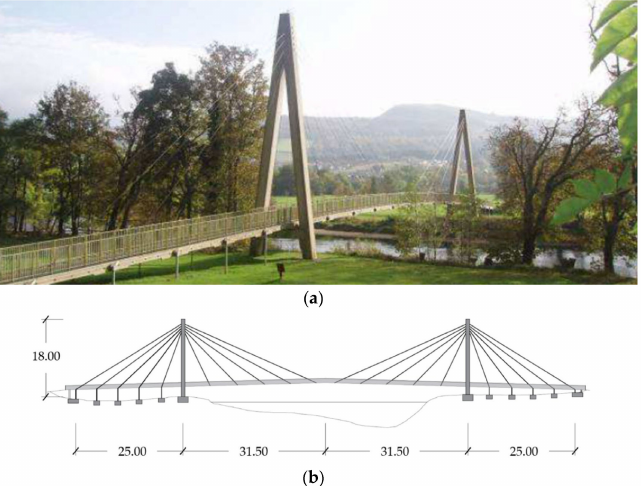
Figure 1. Aberfeldy footbridge: ( a ) the general view [29] and ( b ) the longitudinal section (dimensions in m).